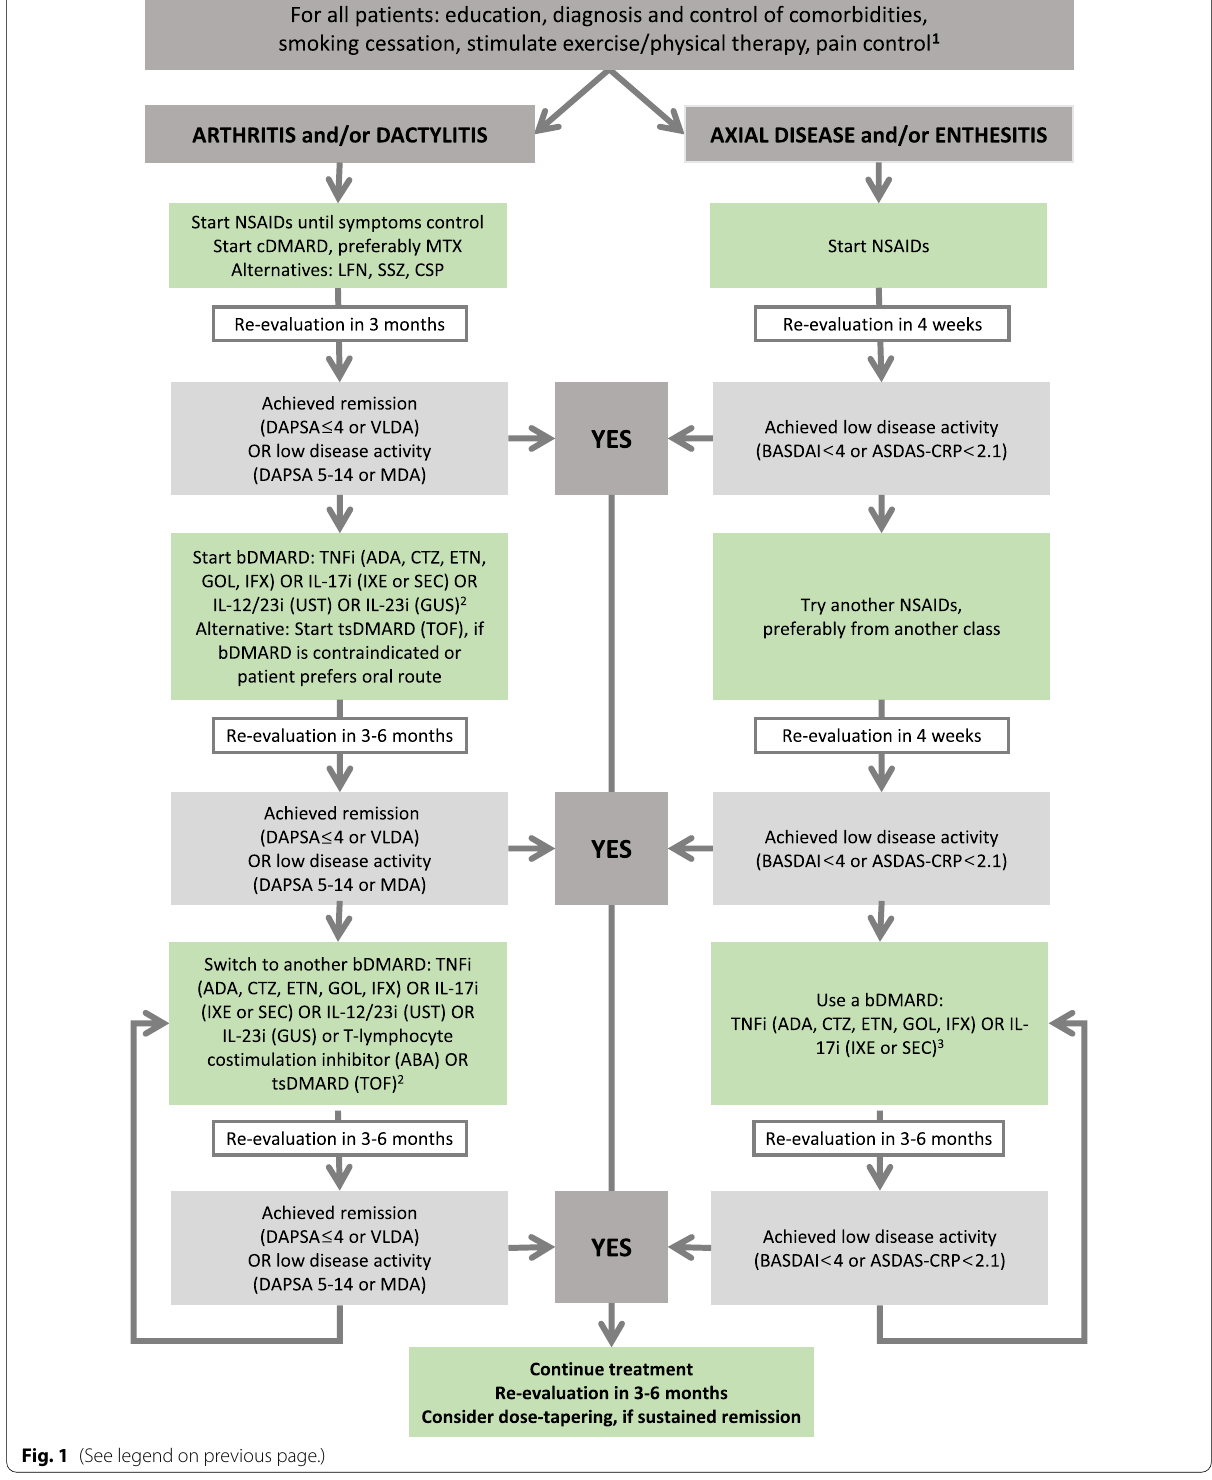
Fig. 1 (See legend on previous